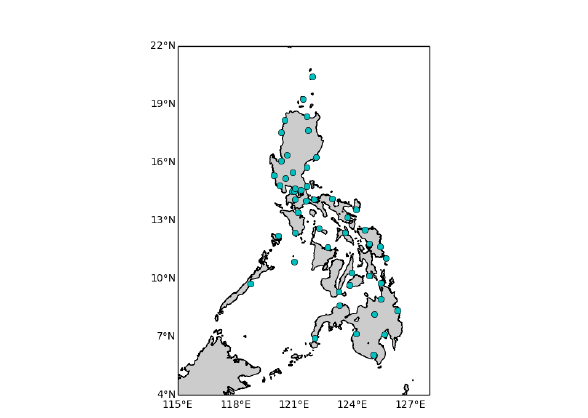
Figure 1. Location of synoptic stations in the